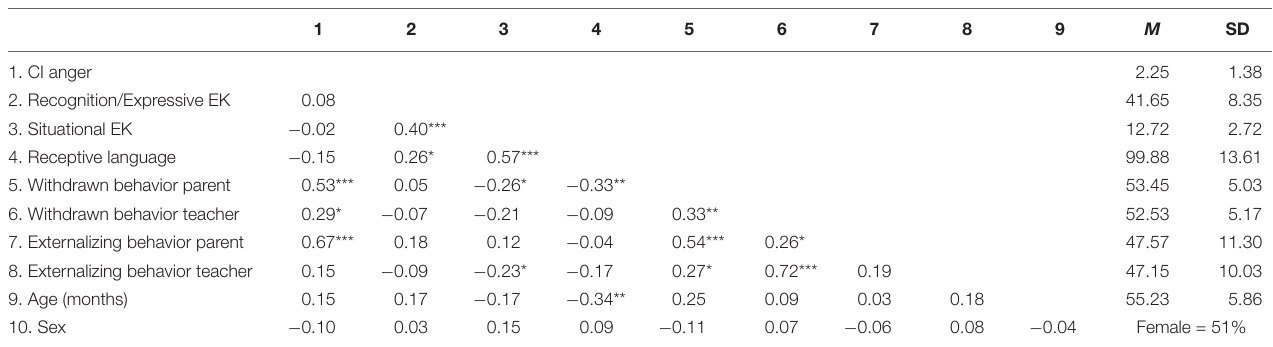
TABLE 1 | Means, standard deviations, and correlations between predictors and outcome